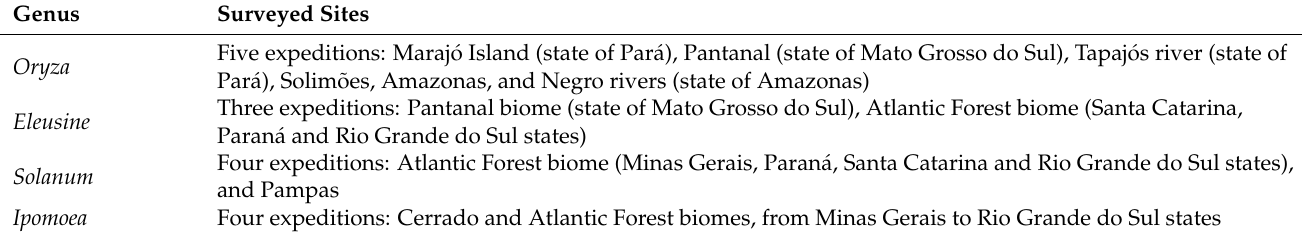
Table 3. Expeditions and sites for collecting germplasm from crop wild relatives of rice, potato, sweet potato, and finger millet.